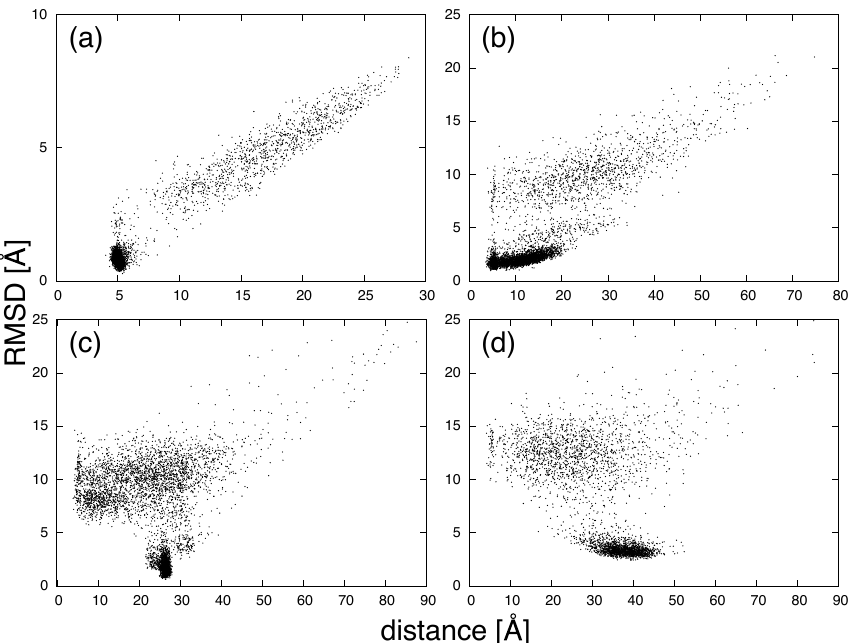
Figure 4. C α -RMSD of ( a ) CLN025, ( b ) mGTT, ( c ) mNuG2, and ( d ) m α 3D as functions of the end-to- end